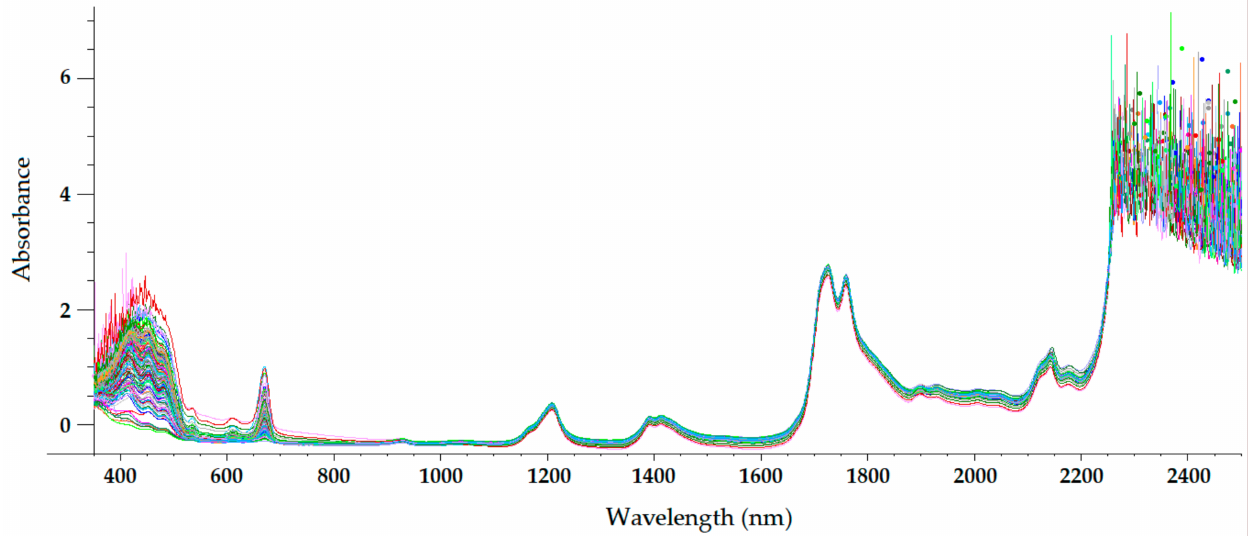
Figure 6. Mean-normalized visible/NIR spectra of 127 olive oils obtained with 10-mm path-length quartz cuvette